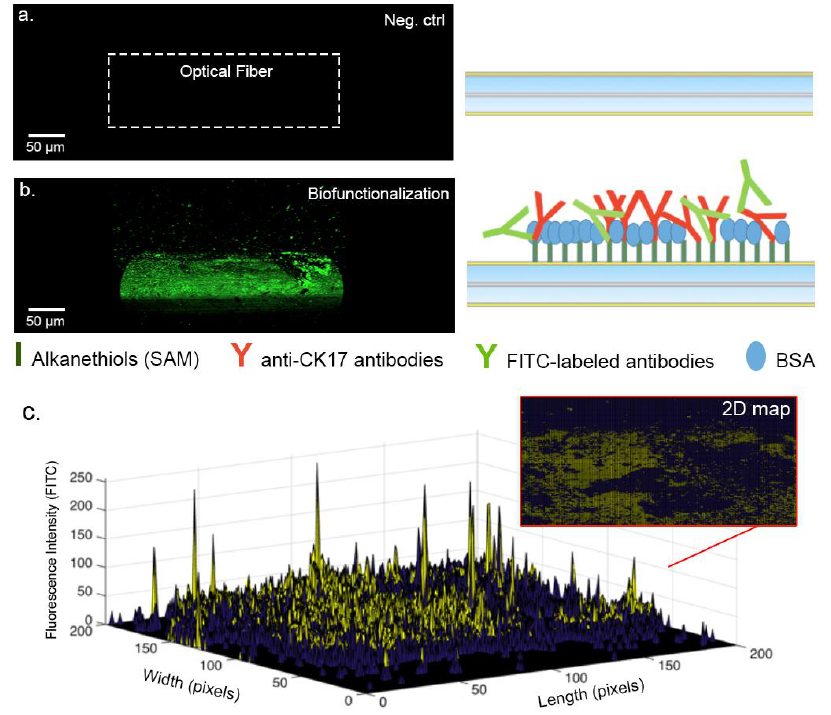
Figure 6. Confocal microscopy analysis performed using fluorescein isothiocyanate (FITC)-labeled antibodies. ( a ) Scans performed with a gold-coated SMF28 optical fiber (no fluorescent antibodies). ( b ) Scan performed with a gold-coated optical fiber covered with the FITC-labeled antibodies and Bovine Serum Albumine (BSA)-blocked. ( c ) 3D map obtained by the fluorescence intensity, bringing approximations of the antibodies covered areas.